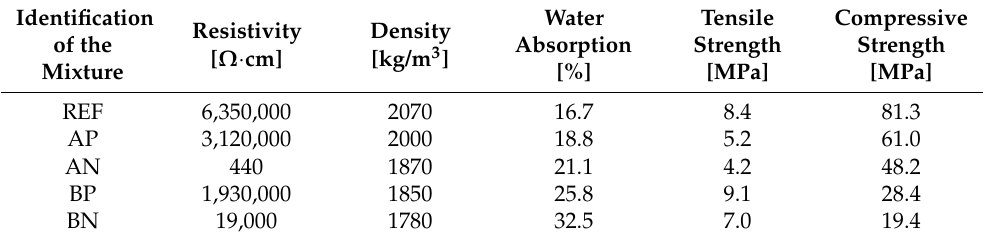
Table 3. Physical and mechanical properties of test specimens.